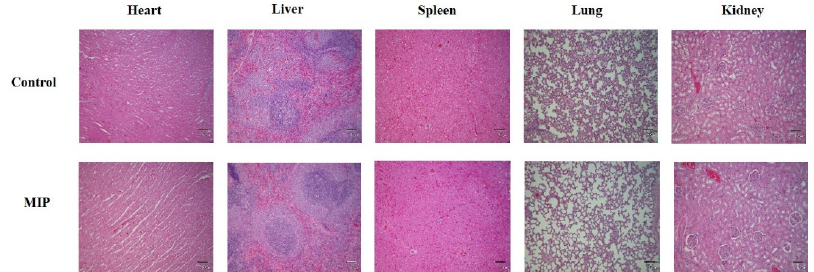
Figure 8. Hematoxylin and eosin (H&E) staining of rat tissues after 28 day subacute oral toxicity experiment with MIPs (40×; scale bar: 100 μm). CTL: control; MIP: mesoporous iron particles. Table 1. Hematology values of rats after 28 day sub-acute oral toxicity experiment with MIPs.